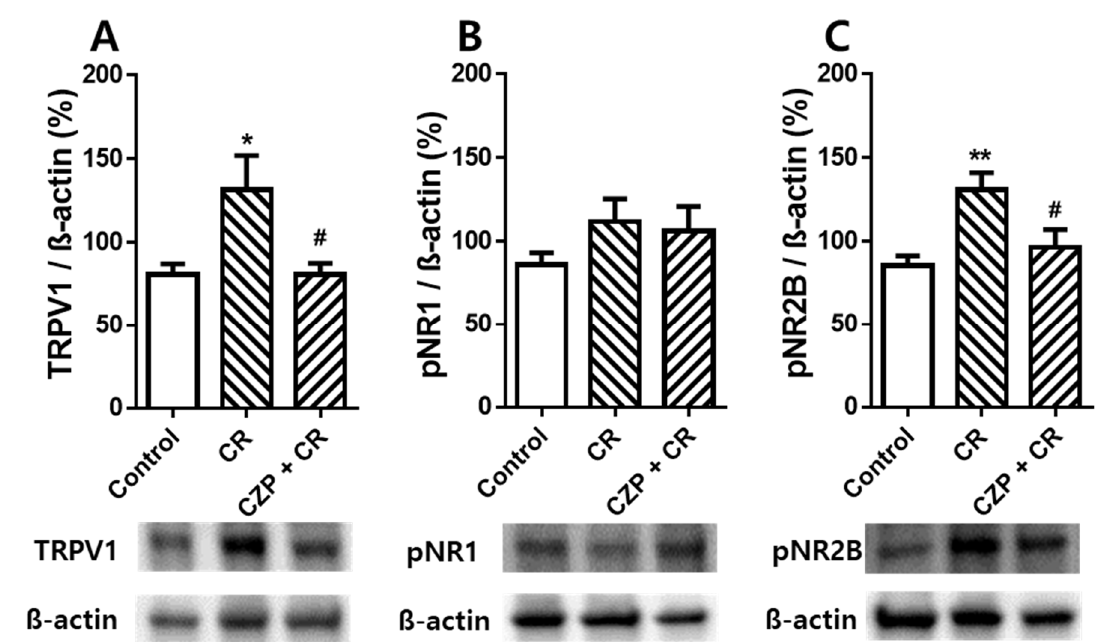
Figure 5. Graphs show the effects of intrathecal capsazepine treatment on TRPV1 ( A ), pNR1 ( B ), and pNR2B ( C ) expression in the lumbar spinal cord of mice with carrageenan-induced inflammation. TRPV1 expression in the spinal cord was significantly higher in carrageenan-injected animals (CR, n = 6) than in the control group (Control, n = 6, * p < 0.05) and was significantly lower in intrathecal capsazepine-treated animals (CZP + CR, n = 6) than in the carrageenan-injected group (# p < 0.05). pNR1 expression levels in the spinal cord were not significantly different among control, carrageenan-injected, and capsazepine-treated groups. Spinal pNR2B expression increased following carrageenan injection compared to that in control rats ( ** p < 0.01), and intrathecal capsazepine-treated mice exhibited significantly lower spinal pNR2B expression compared to that in the carrageenan-treated group (# p < 0.05).